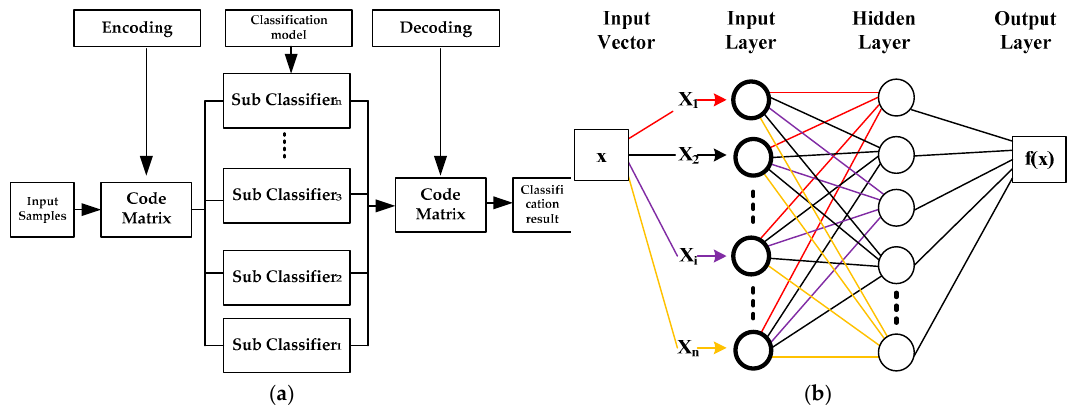
Figure 4. The block diagram of the models: ( a ) Error correcting output coding support vector machine-one versus rest (ESVM-OVR) and ( b ) artificial neural network (ANN). Table 3. The errors correcting code matrix for three classes and three code